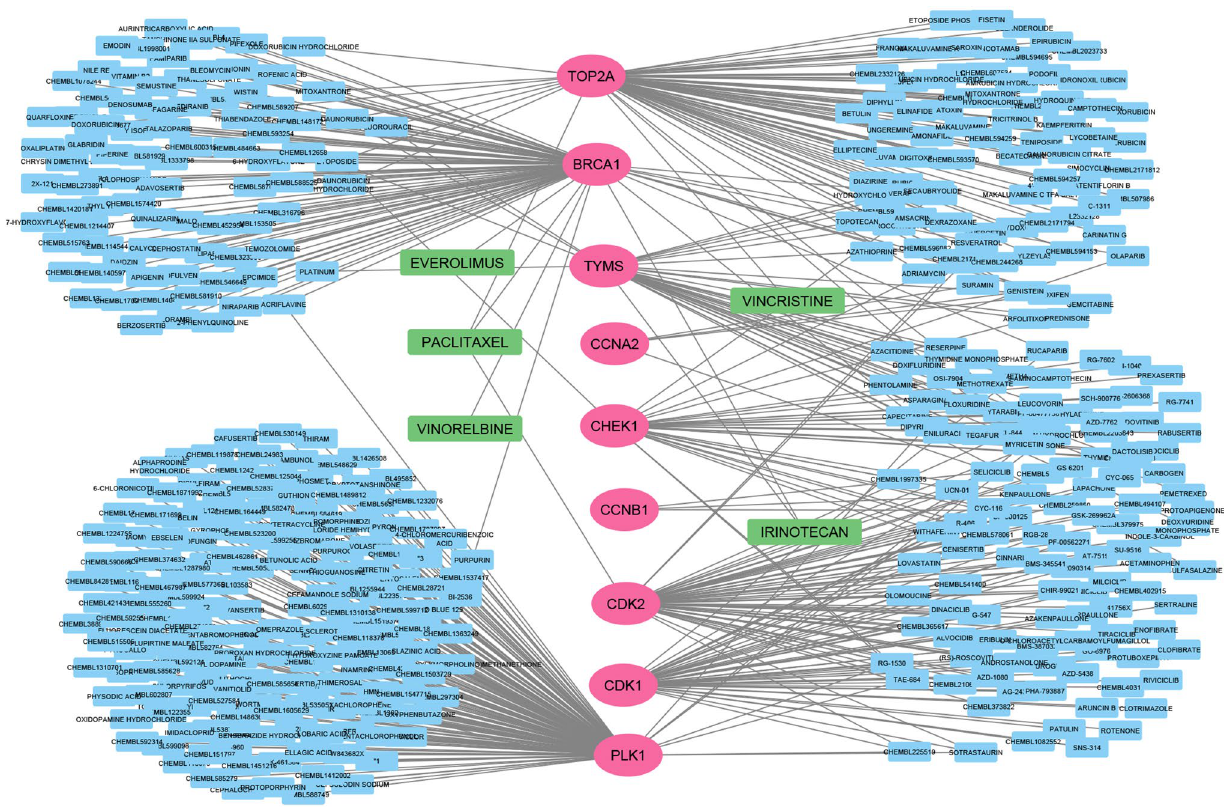
Fig. 7 Gene-Drug interactions based on DGIdb and the network consists of 467 nodes and 539 edges. It contains proposed top-ranked 10 hHubGs (magenta color), drugs (deep sky blue) and the five drugs in light green (Paclitaxel, Vincristine, Everolimus, Vinorelbine, Irinotecan) indicated common drugs along with our proposed top-ranked 10